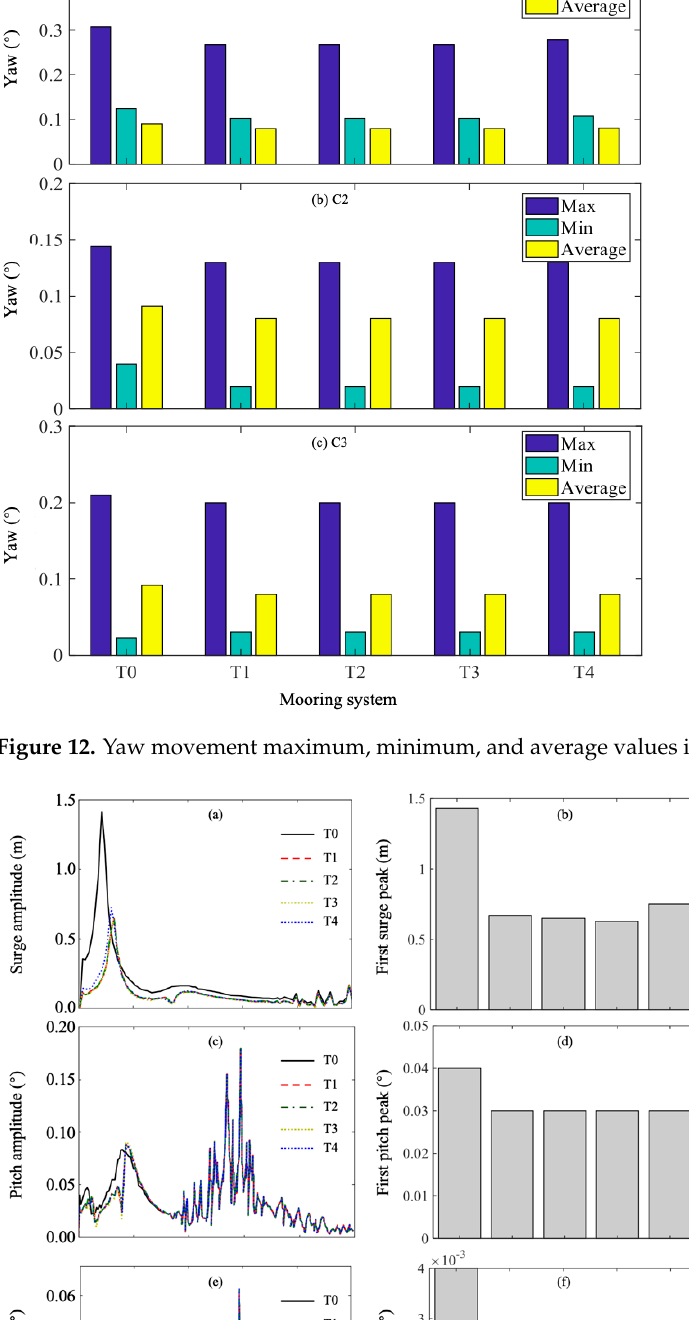
Figure 11. Pitch movement maximum, minimum, and average values in ( a ) C1, ( b ) C2, and ( c ) C3.